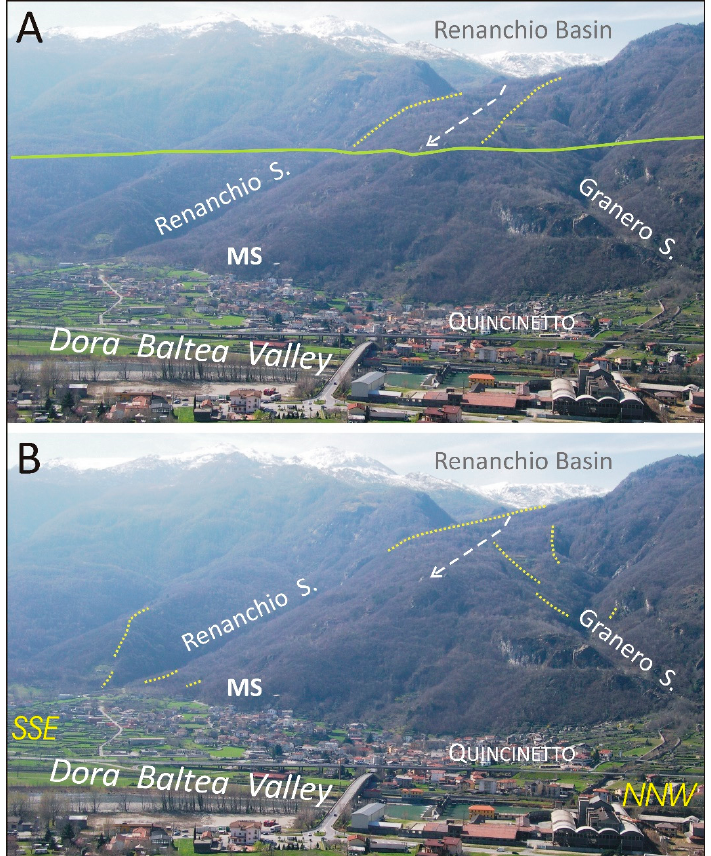
Figure 7. Location of the Montellina Spring (MS) along the right slope of the Dora Baltea Valley during LGM ( A ) and Lateglacial ( B ). ( A ) Downstream of the high Renanchio Basin (sector 4), clearly shaped by the Renanchio Glacier, a buried glacial valley floor (white arrow) is assumed, covered by the Renanchio Glacier sediments forming large lateral moraines (yellow lines) (sector 3). This valley floor ends at approximately 675 m, where the confluence of the tributary glacier with the main Dora Baltea Glacier was likely located (green line). The lower strip of the slope (under the green line) (sectors 2 and 1) is essentially shaped by the Dora Baltea Glacier. ( B ) The retreat of the main Dora Baltea Glacier during the Lateglacial favors the subsequent advance of minor lateral glaciers (Renanchio and Granero glaciers) into the current incisions until the main valley